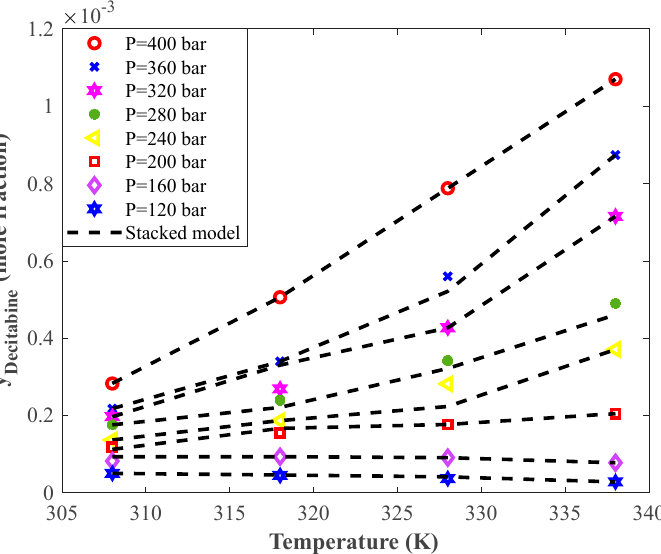
Figure 7. The experimental and modeling profiles of the effect of temperature on the solubility of the anticancer drug Decitabine in supercritical CO 2 .